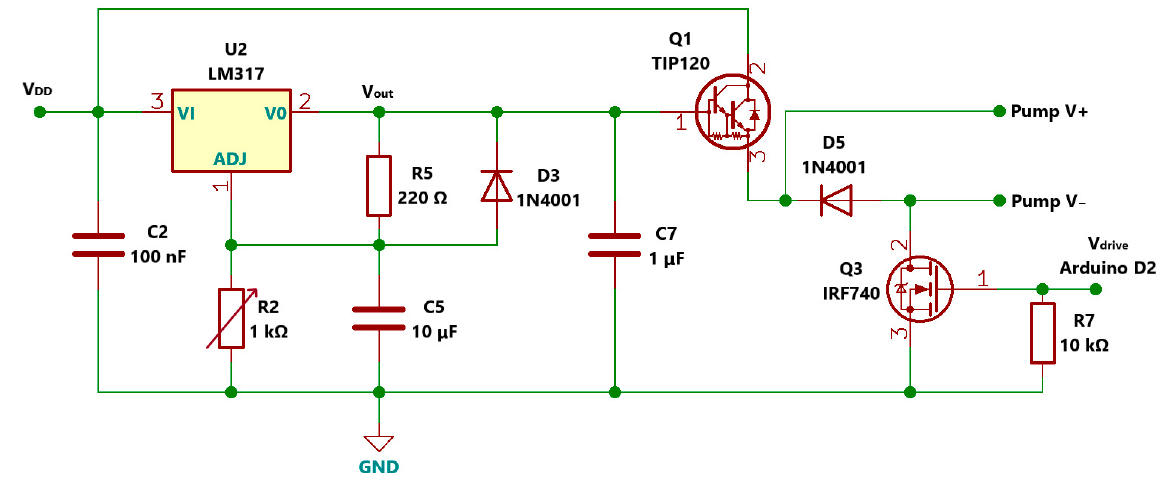
Figure 3. Pump power supply and control circuit operated by Arduino digital pin D2.